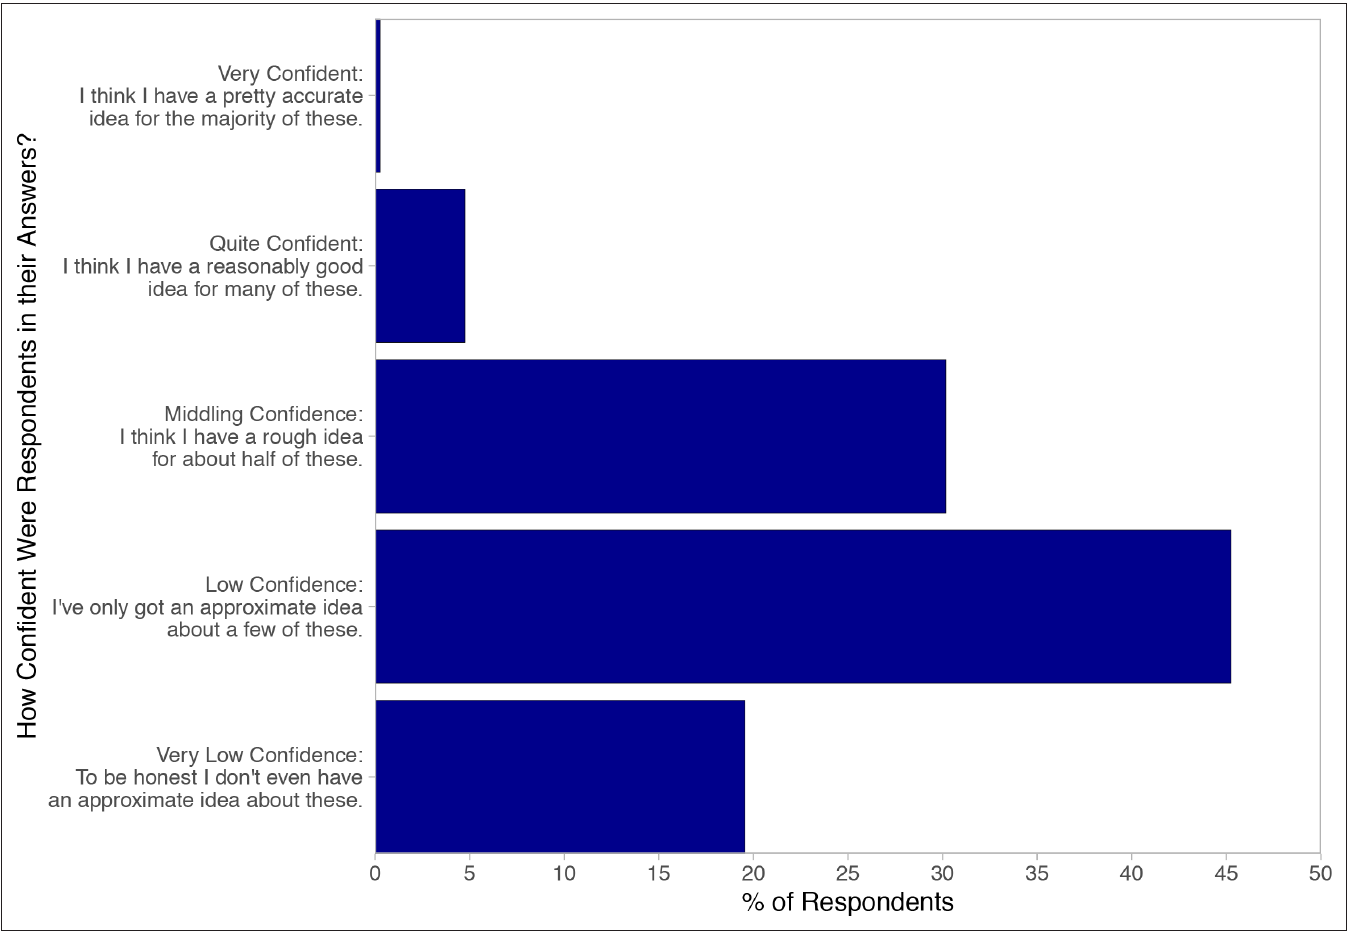
Figure 5 Survey responders’ confidence in their